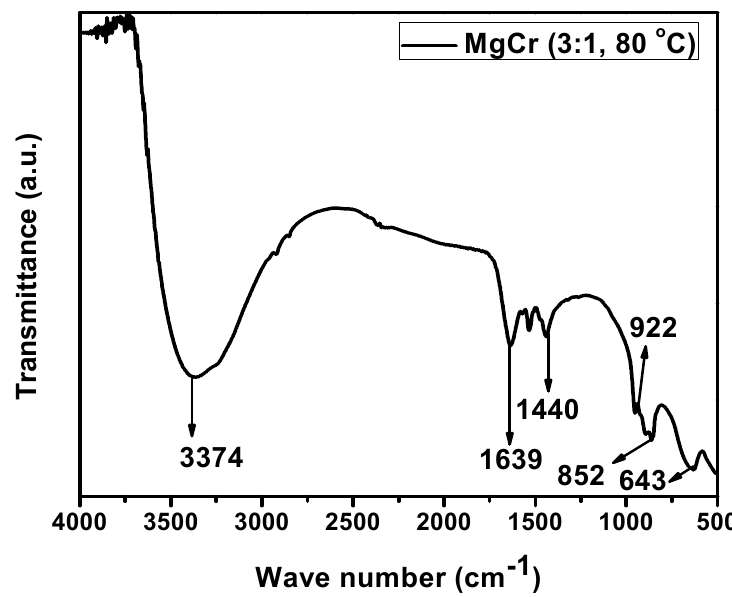
Figure 4. FTIR spectrum of exfoliated MgCr − LDH (3:1, 80 °C).